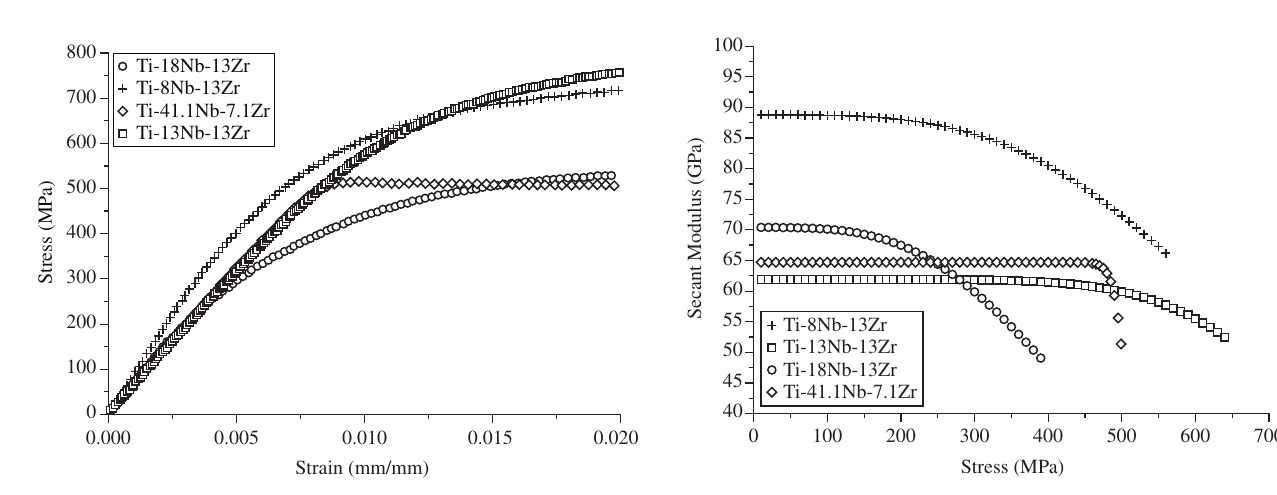
Figure 3. Stress-strain curves for Ti-Nb-Zr alloys cut-off around 2% total strains.